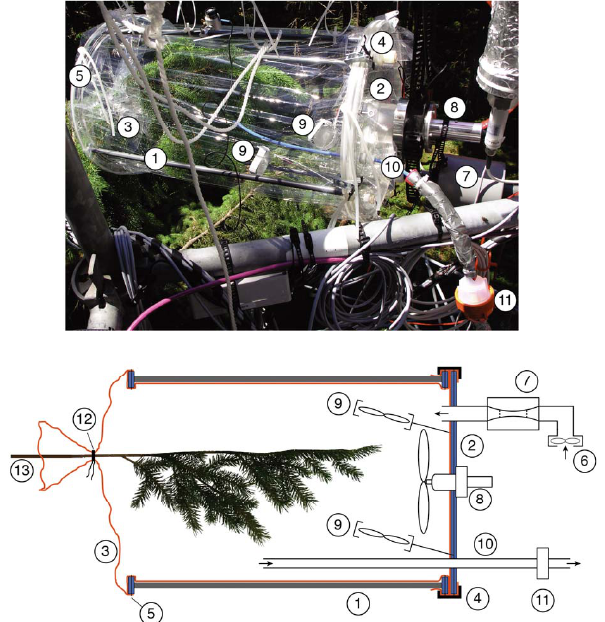
Fig. 4. Photograph and schematic drawing of a dynamic chamber Figure 4. Photograph and schematic drawing of a dynamic chamber consisting of: (1) PVC 3 consisting of: (1) PVC (grey parts) frame, (2) acrylic glass (blue (grey parts) frame, (2) acrylic glass (blue parts) lid, (3) FEP film (red parts in the scheme), (4) 4 parts) lid, (3) FEP film (red parts in the scheme), (4) clamp to attach clamp to attach lid to frame, (5) silicon straps, (6) inlet fan, (7) air mass flow sensor, (8) 5 lid to frame, (5) silicon straps, (6) inlet fan, (7) air mass flow sensor, Teflon propeller, (9) mixing fan, (10) sample tube for chamber air, (11) filter, (12) closure, 6 (8) Teflon propeller, (9) mixing fan, (10) sample tube for chamber (13) plant material. 7 air, (11) filter, (12) closure, (13) plant